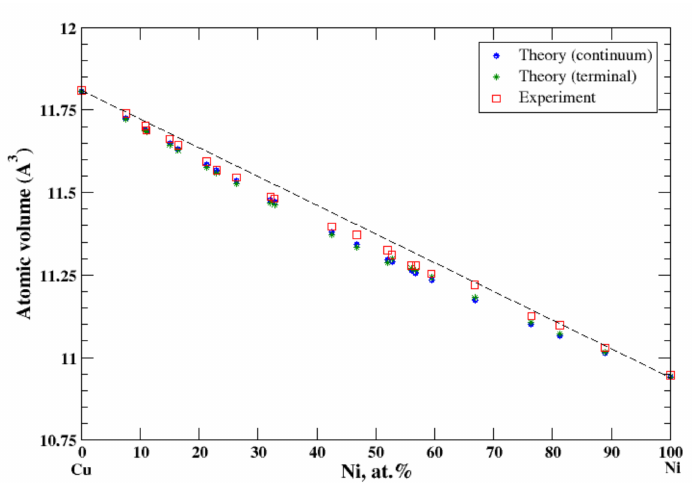
Figure 10. Atomic volume vs. concentration for Cu-Ni alloy system. The experimental data are from Ref. [16] (p. 592 and p. 601).